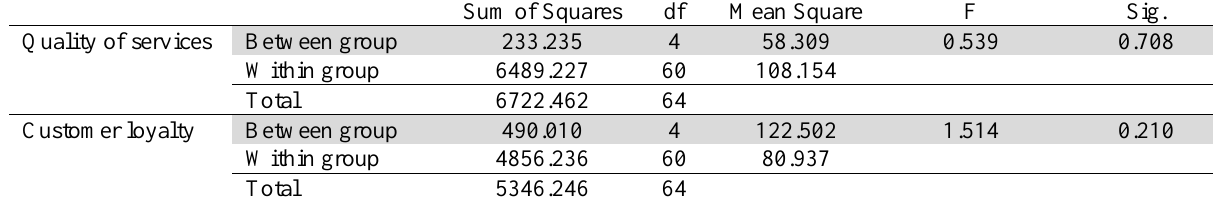
The summary of ANOVA test on the effects of age on quality of services and loyalty Sum of Squares df Mean Square F Sig. Quality of services Between group Customer loyalty